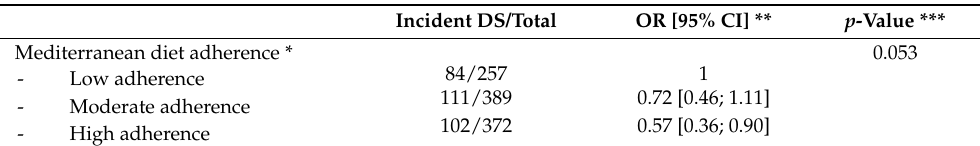
Table 4. Association between Mediterranean diet adherence and the risk of depressive symptomatol- ogy (i.e., CES-D score ≥ 16) ( N = 1018).